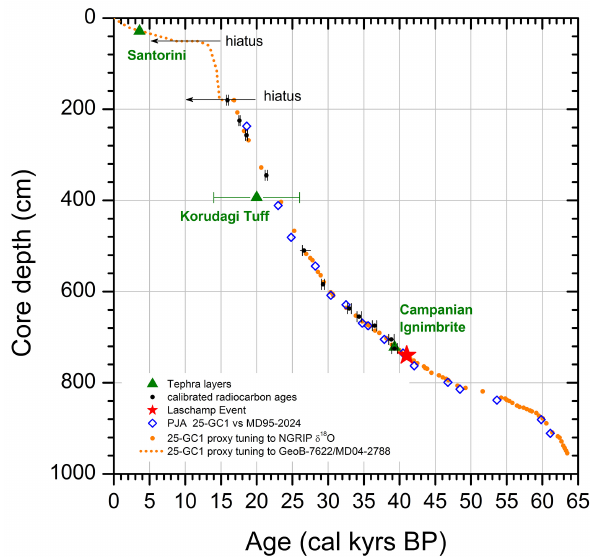
Fig. 2. Stratigraphical framework for Black Sea core 25-GC1: San- torini tephra (Guichard et al., 1993; Friedrich et al., 2006), Koruda˘gı tephra (Kuzucuoglu et al., 1998), Campanian Ignimbrite tephra (De Vivo et al., 2001; Pyle et al., 2006), Laschamp Event (Bonhommet and Babkine, 1967; Gillot et al., 1979; Guillou et al., 2004; Plenier et al., 2007; Nowaczyk et al., 2012), PJA (paleointensity based on anhysteretic remanent magnetization) – relative paleointensity of 25-GC1 (Nowaczyk et al., 2012) tuned to MD95-2024 (Stoner et al., 2000), 25-GC1 proxy tuning to North Greenland Ice core Project (NGRIP) δ 18 O record (Svensson et al., 2008) and to the Black Sea sediment records GeoB-7622 (Lamy et al., 2006) and MD04-2788 (Kwiecien et al.,